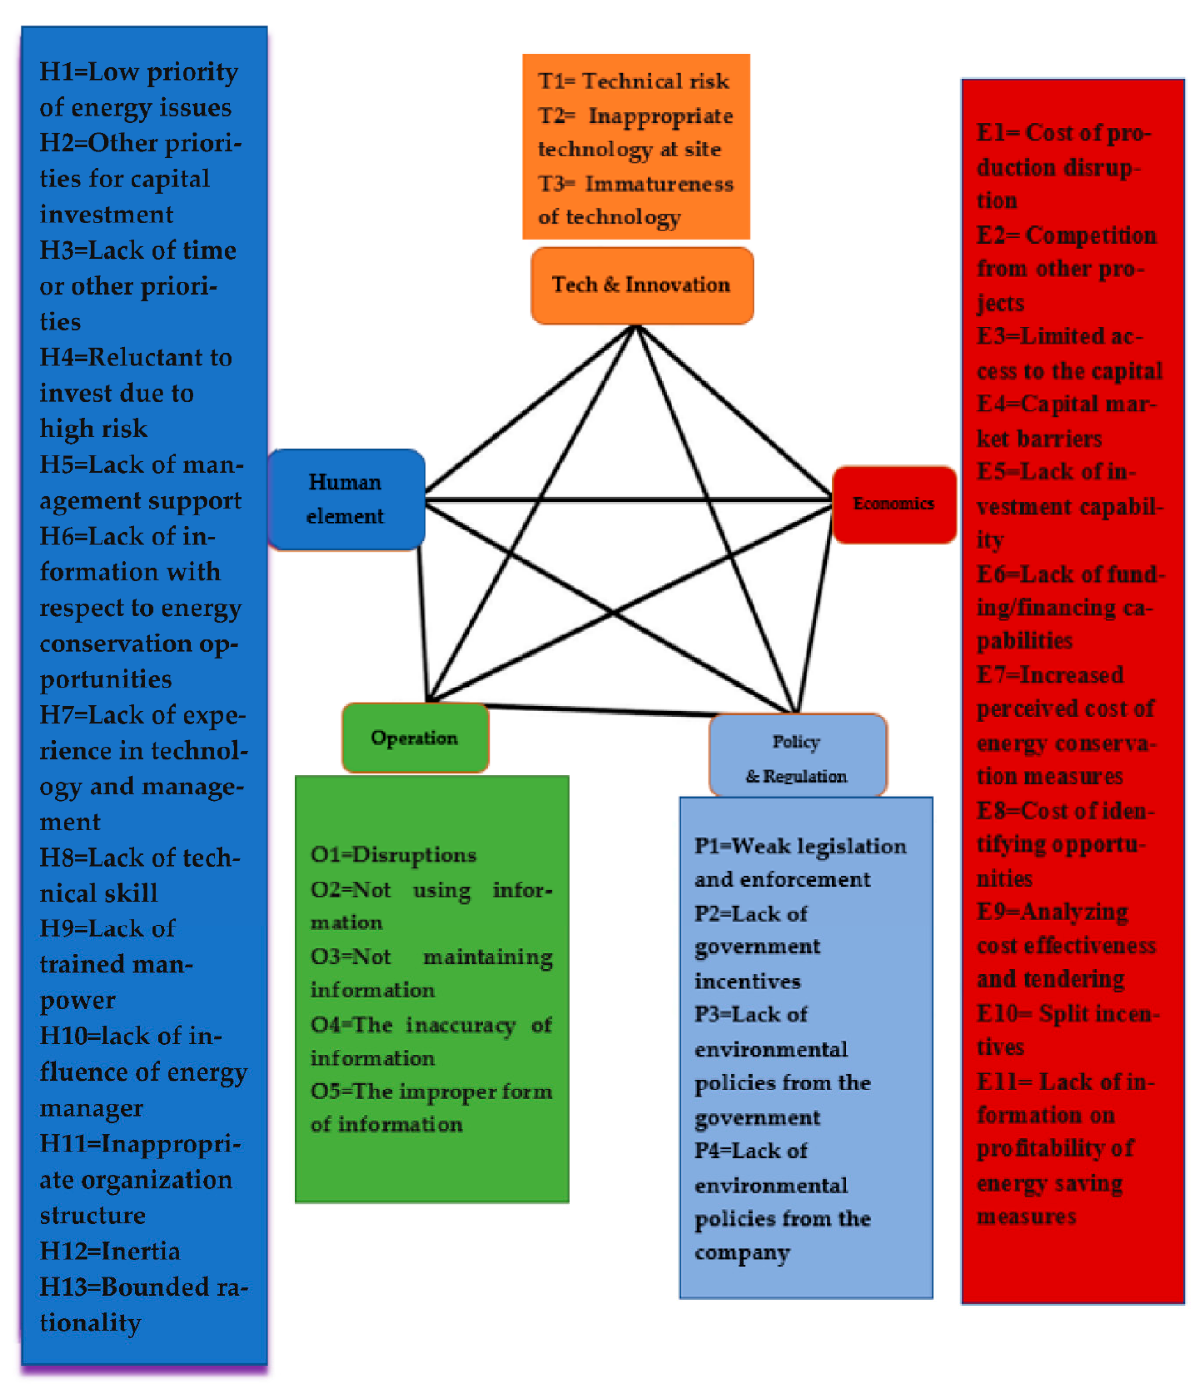
Figure 2. Categorization of key barriers in the shipbuilding industry. Resource; [12,22,32,33,38,44,69,71,74,106,127–132].